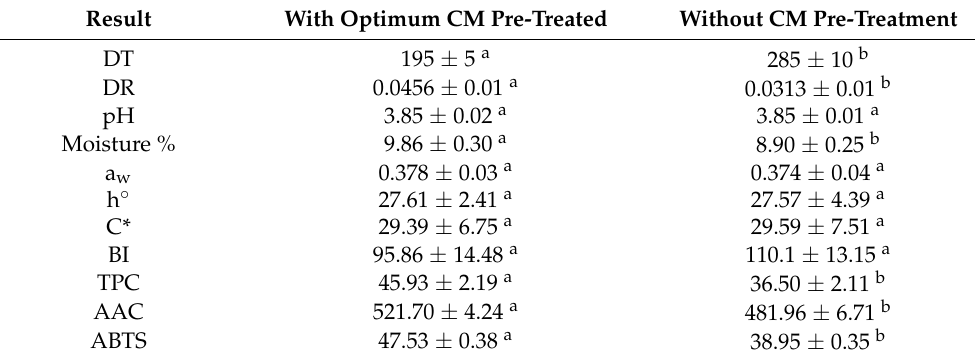
Table 5. Results of analyses with and without CM-pre-treated dried